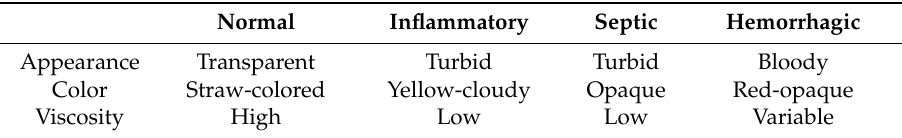
Table 1. Macroscopic classification of synovial